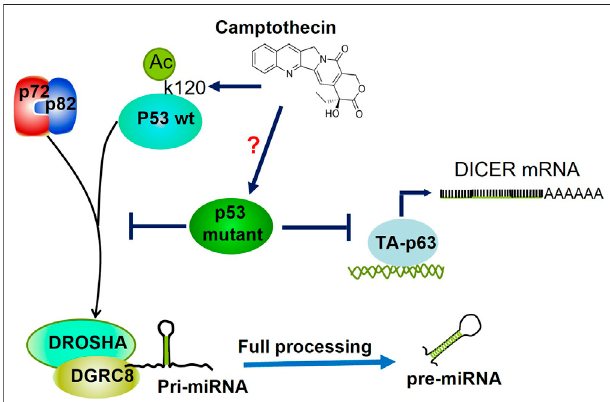
FIGURE 6 | Regulation of miRNAs processing by Mutant p53. Mutants of p53 hinder the association between RNA helicases p72/82 and the microprocessor complex (DROSHA-DGCR8), thereby inhibiting miRNAs ’ maturation post-transcriptional level. Camptothecin induces acetylation of K120 within the DNA Binding Domain of p53, which augments its association with p72/p82. Whether this drug may revert the poor association of p53 mutants with p72/p82 is not known. p53R273H inhibits the transcription of DICER mRNA through both direct and indirect inhibition of transactivation of